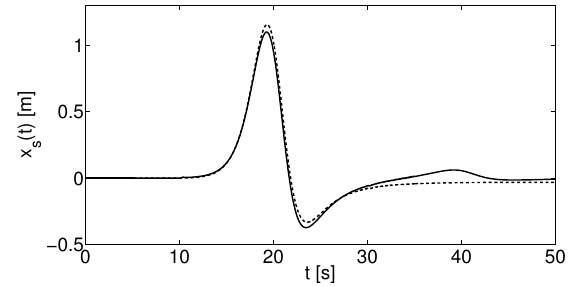
Figure 8. Comparison of the shoreline movement of Choi et al. Fig. 8. Comparison of the shoreline movement of Choi et al. (2011) (2011) (dashed line) and the LSWE with an EBC simulation (solid (dashed line) and the LSWE with an EBC simulation (solid line) for line) for the solitary wave case. solitary wave case.